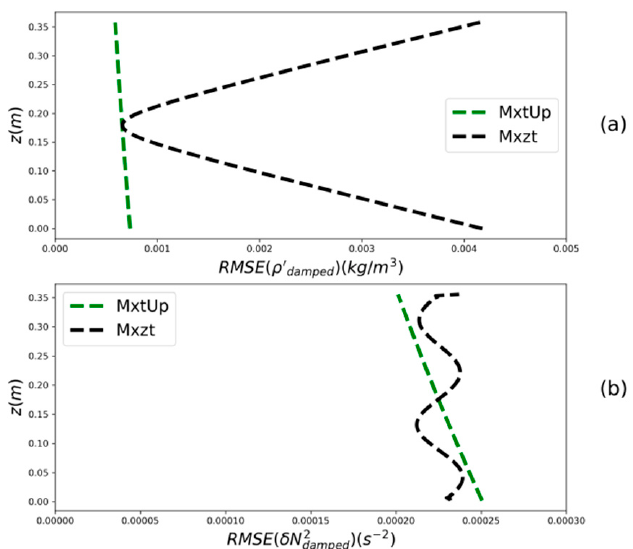
Figure 3. Vertical profiles of the root mean square (rms) error, averaged over x and t , of the reconstructed fields for IW damped resulting from the Mxzt and MxtUp methods. ( a ) rms error of δρ . ( b ) rms error of δ N 2 .